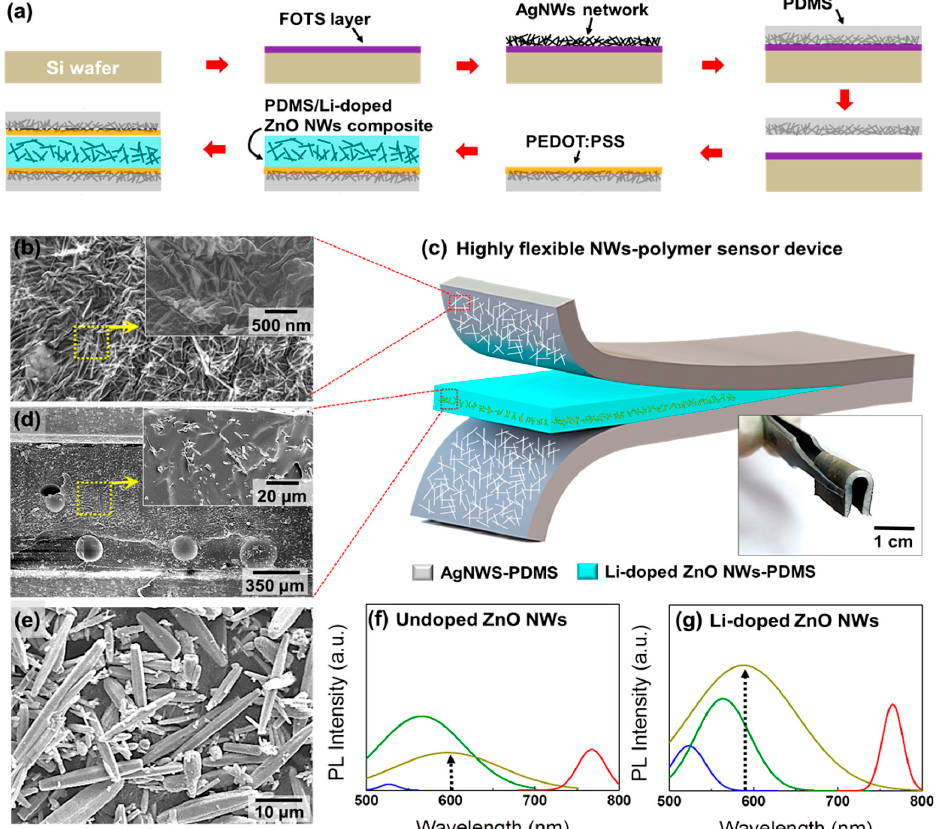
Figure 14. ( a ) Schematic illustration of the sensor fabrication process: composite layer, containing piezoelectric Li-doped ZnO NWs and PDMS, is sandwiched between two poly (3,4-ethylenedioxythiophene) polystyrene sulfonate (PEDOT:PSS)-coated Ag NW electrodes embedded in the PDMS; ( b ) SEM of the AgNW network, which is seamlessly connected on the PDMS surface. The inset shows a magnified view of the Ag NWs on the PDMS; ( c ) Schematic representation of the sensor device consisting of two main parts: resistive and piezoelectric sensing elements. The inset shows the flexibility of the device; ( d ) Cross-section of the device SEM; ( e ) SEM of as-synthesized Li-doped ZnO NWs; ( f ) photoluminescence (PL) spectra of undoped ZnO NWs, and ( g ) Li-doped ZnO NWs. The yellow emission explicitly indicates the Li-doping in ZnO. Adapted figure from [97] with permission from copyright (2017), American Chemical Society (Washington, DC, USA).